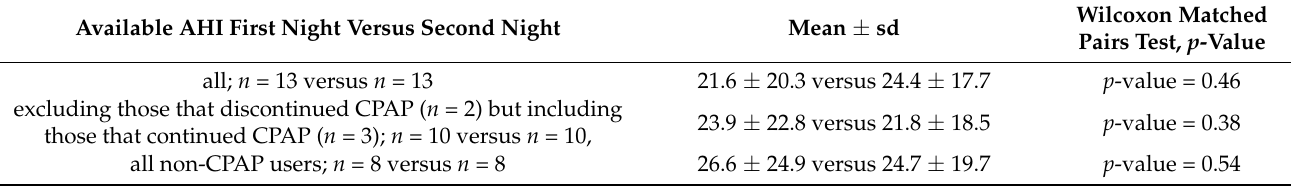
Table 2. Comparison of first- and second-night